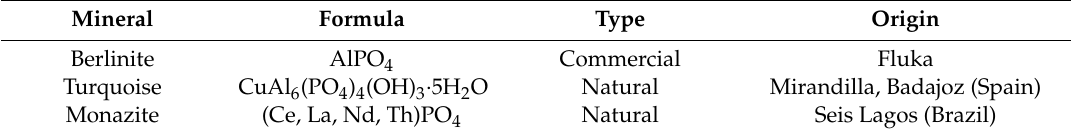
Table 1. Mineral phosphates tested in the bioleaching experiments using A. niger .